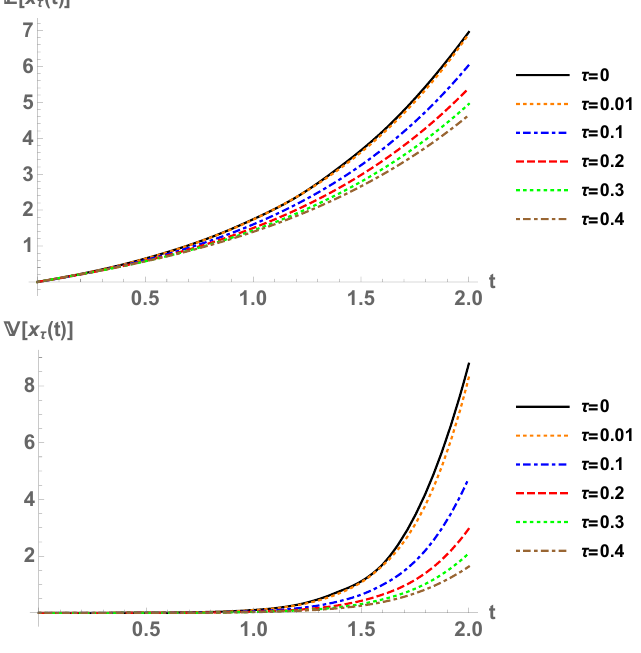
Figure 1. Expectation (up) and variance (down) of x τ ( t ) , Example